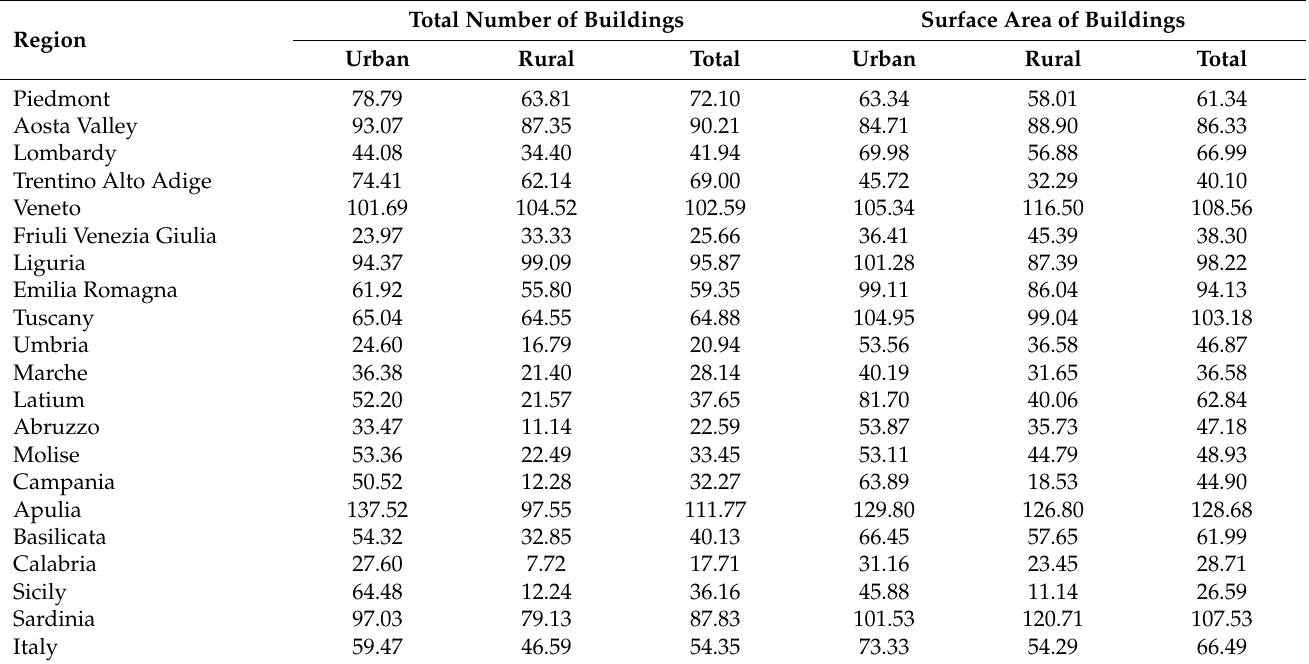
Table 3. OSM-to-BODA coverage ratio (calculated separately for the total number of buildings and the total surface area of buildings) by Italian region and urban/rural district.